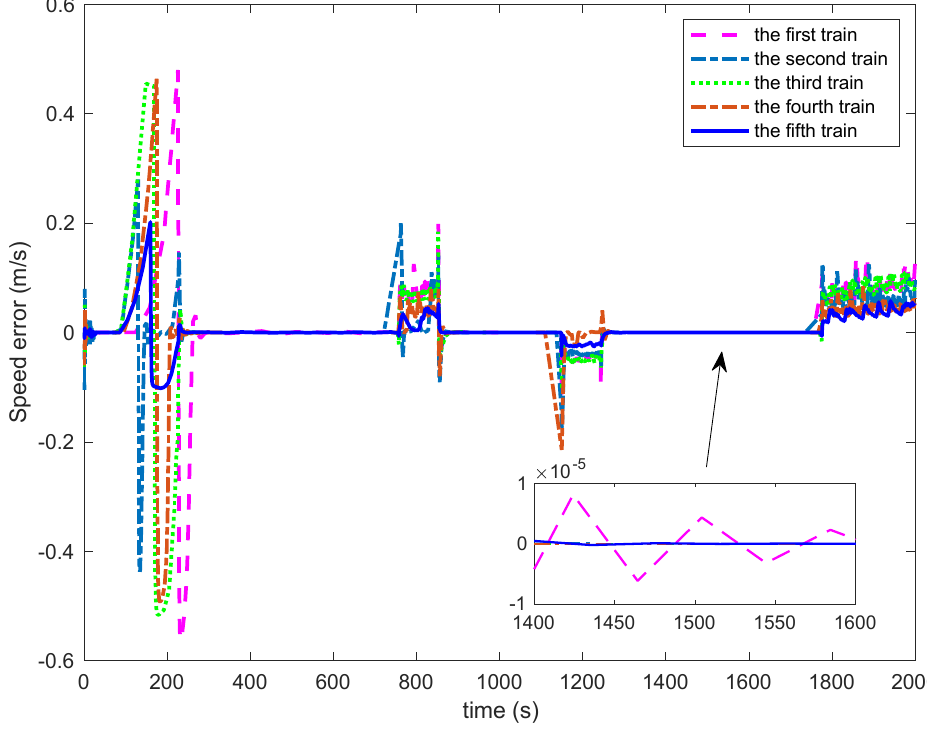
Figure 5. Speed tracking error of each train.